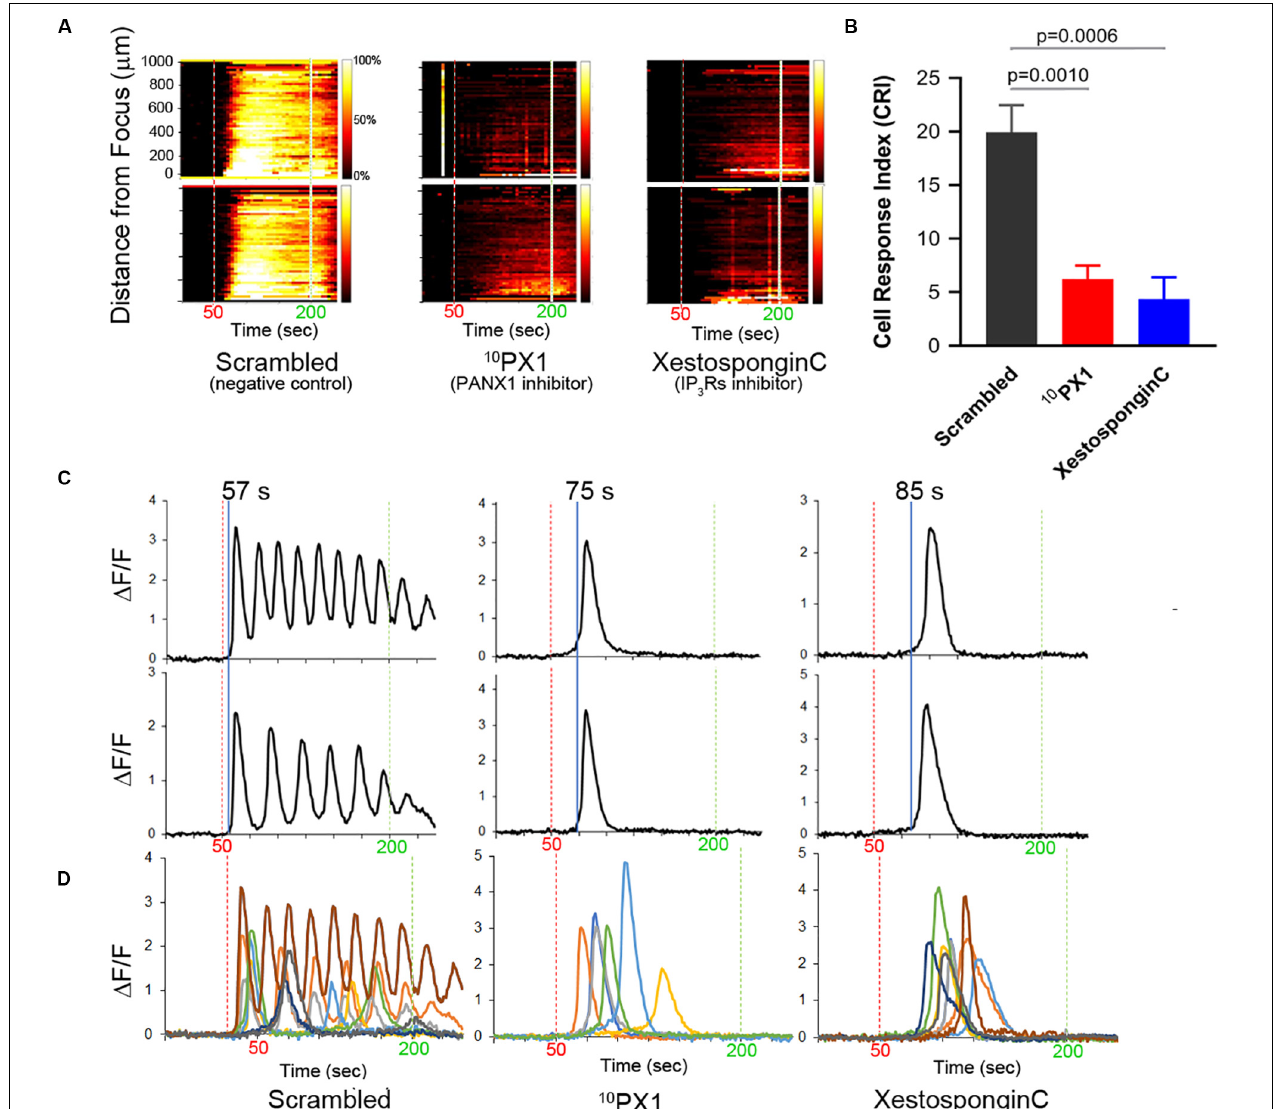
FIGURE 3 | Treatment of PC-3 cells with 10 PX1 (PANX1 inhibitor) abolishes the normal FUS-induced Ca 2 + oscillation response but uncovers single Ca 2 + transients. (A) Left column, the cells exhibited strong Ca 2 + responses at 20 min after 200 µ M scrambled peptide application as a control. Center column, cells were stimulated at 20 min after 200 µ M 10 Panx1 peptide ( 10 PX1) application, and the responses were partly reduced. Right column, 20 min after 2 µ M Xestospongin C (XC) application, the responses were also partly reduced. Two representative cells were shown in each treatment. (B) Quantitative CRI values of the inhibitor